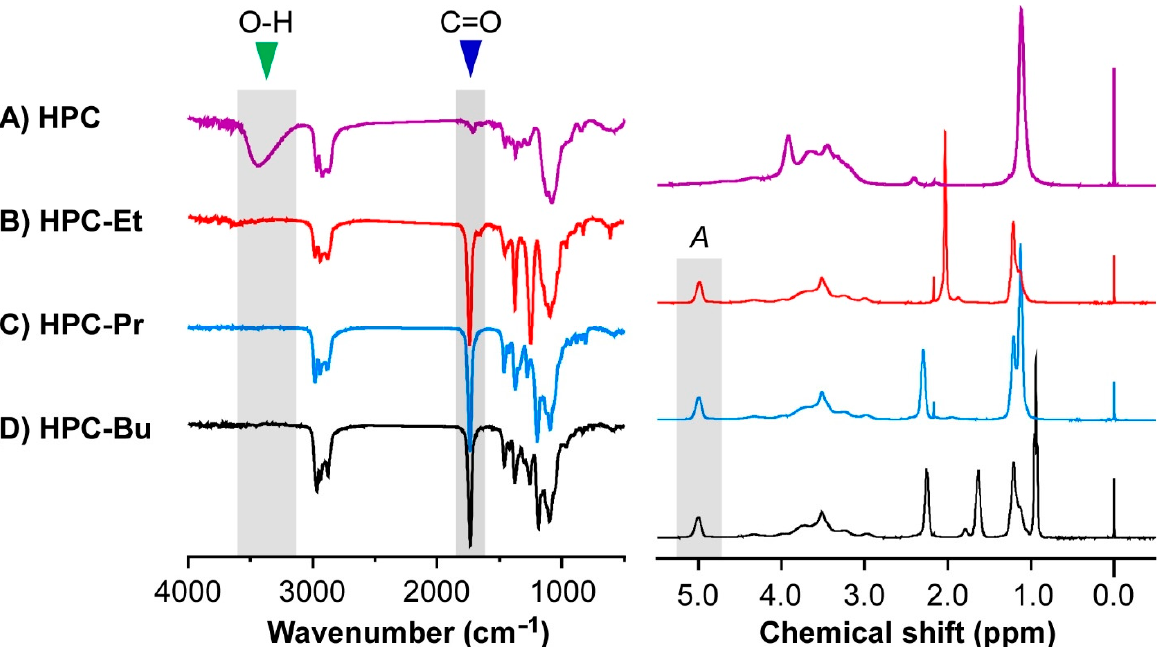
Figure 2. Attenuated total reflection (ATR) FT-IR spectra (left side) and 1 H-NMR spectra (right side) of HPC (A; purple lines), HPC-Et (B; red lines), HPC-Pr (C; blue lines), and HPC-Bu (D; black lines). Two peaks at 1700 cm − 1 (indicated by blue triangle) and 3100 cm − 1 to 3600 cm − 1 in the ATR FT-IR spectra (indicated by green triangle) are assigned to C=O stretching vibration and O-H stretching vibration, respectively. A is the integrated values of the peaks appearing at 5.00 ppm in the 1 H-NMR spectra, meaning the assignment of the methine protons of the esterified hydroxypropyl groups.